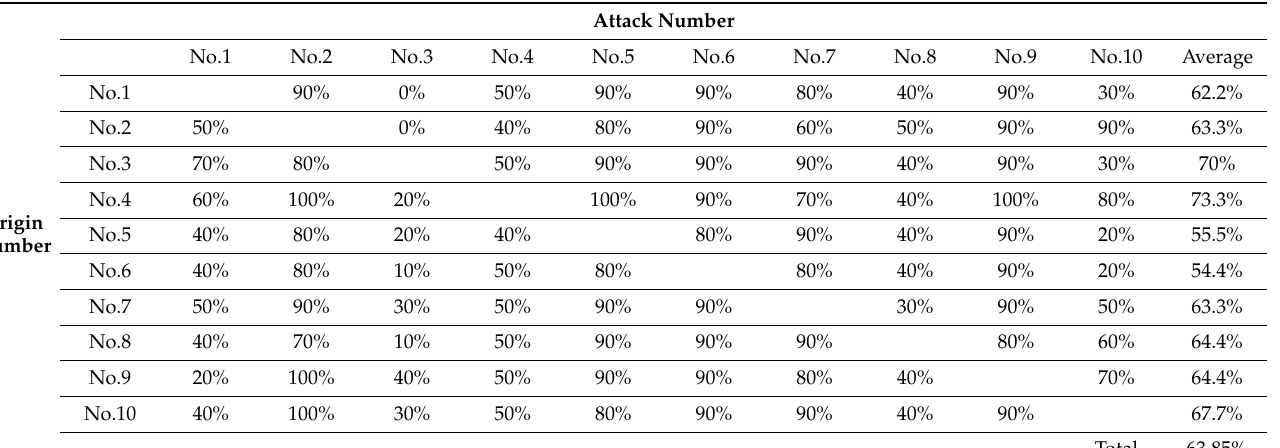
Table 11. The attack success rate of a single target for impersonation attacks in the physical world on a face recognition system with 22 persons in the